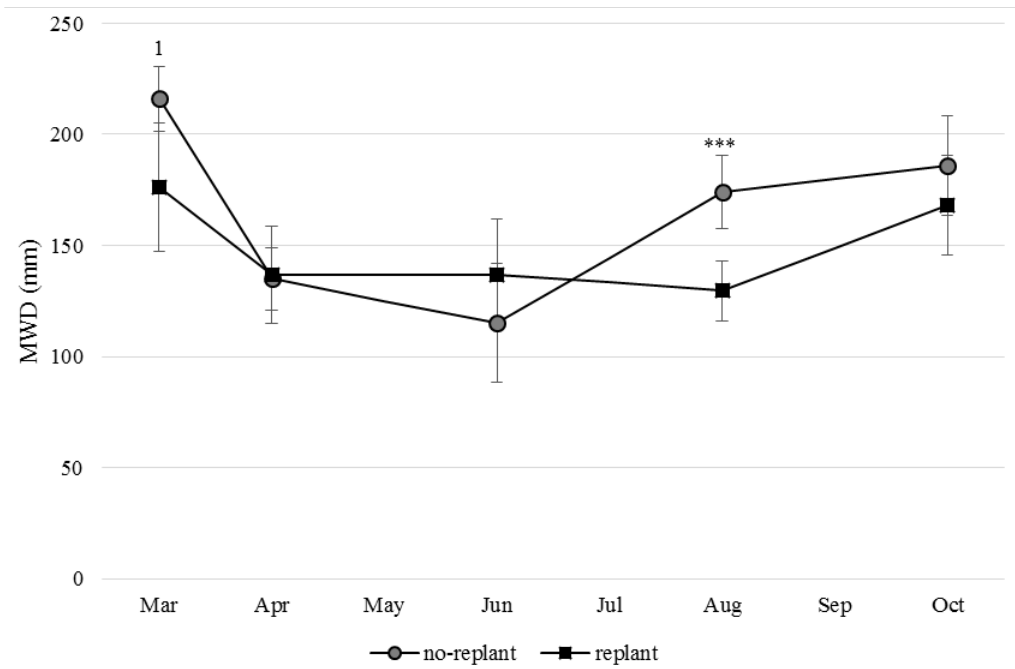
Figure 3. Mean weight diameter (MWD) of no-replant soil (nr) and replant soil (r). Significances calculated between nr and r soil. α = 0.05, *** p ≤ 0.001, 1 p ≤ 0.10. Table 1. Mean mass values (g) of sieve-size fractions from ≤ 125 µm to 6300 µm in no-replant soil (nr) and replant soil (r). Sieve-Fraction (µm) Soil